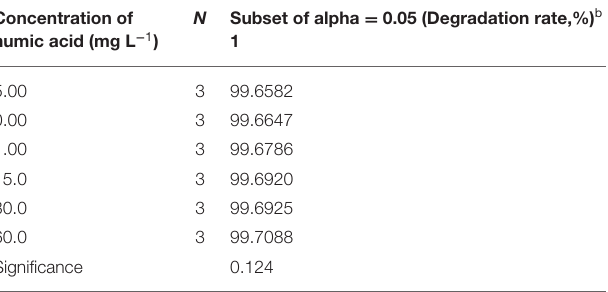
TABLE 5 | Analysis of variance on degradation of colistin by ferrate (VI) in the presence of humic acid a . Concentration of humic acid (mg L − 1